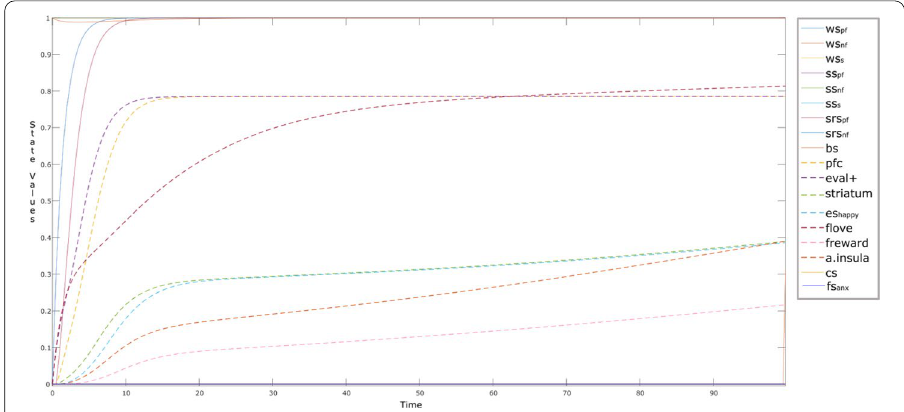
Fig. 2 Simulation of the model when ws pf